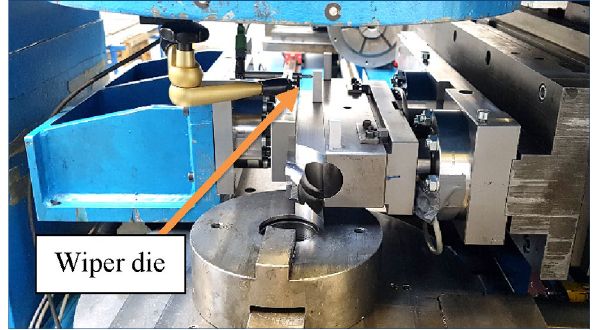
Fig. 18 Experimental setup for stiffness measurement on the wiper die